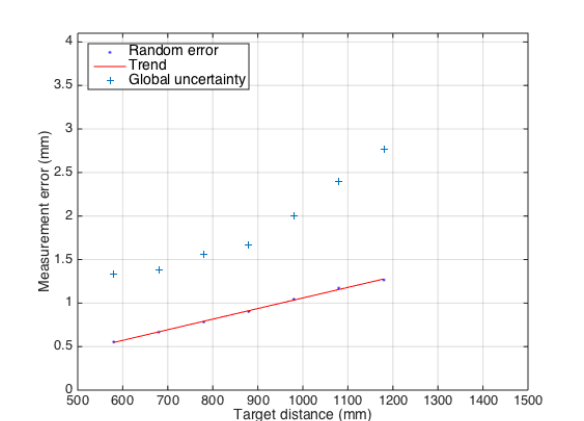
Figure 8. Structure Sensor global uncertainty, random error and quadratic fitting on the random error ( ρ =0.9992).